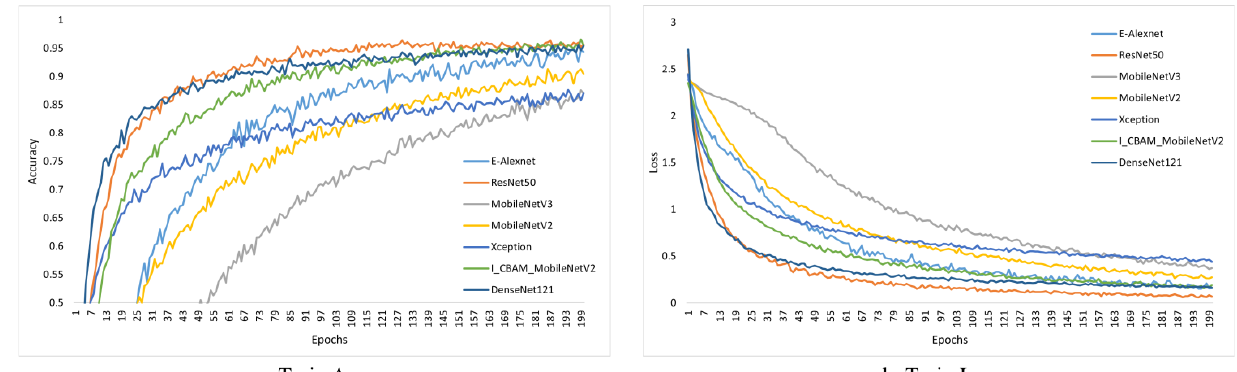
Figure 10. Training accuracy and loss of different models.